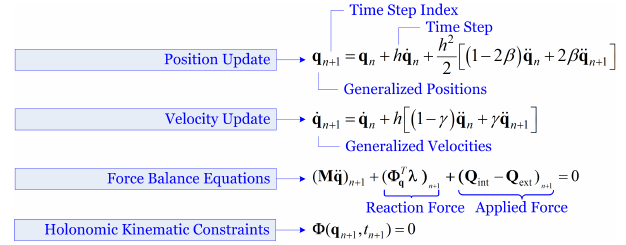
Figure 18 : The discretized equations of motion for Chrono ::Flex Figure 18. The discretized equations of motion for Chrono ::Flex (fully implicit). (fully